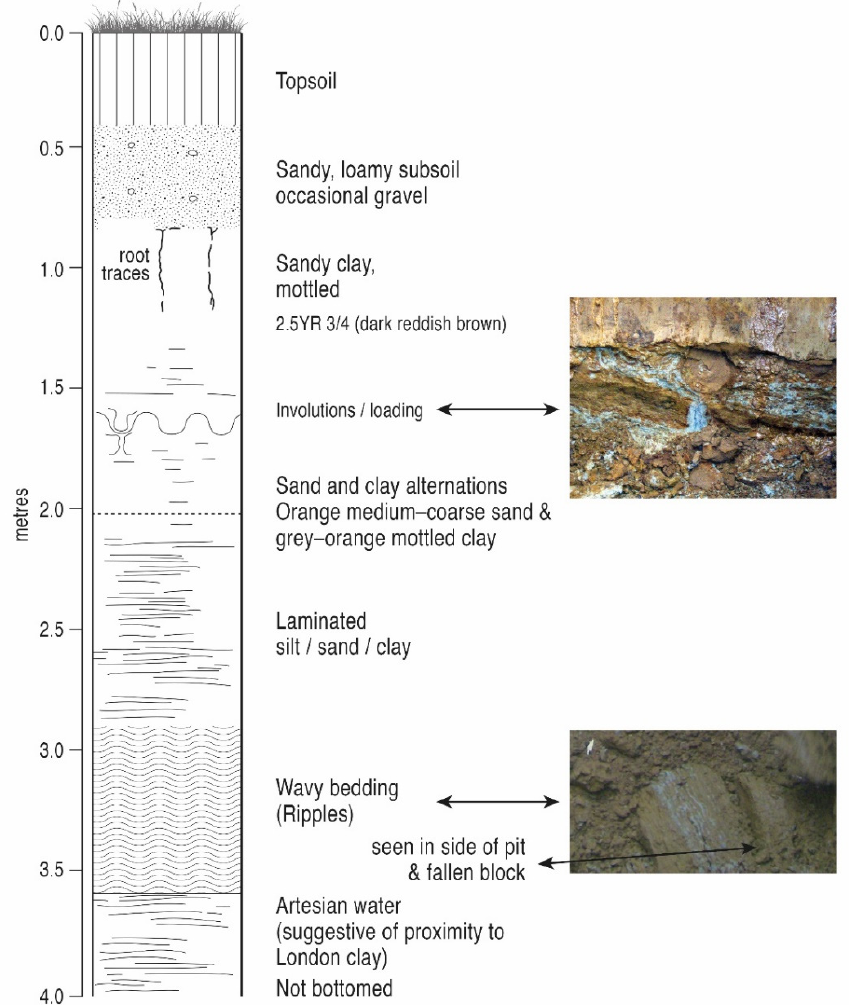
Figure 11. The Pound Farm 2014 archaeological assessment, test pit 6, the deepest excavated at the site. Photographs are inserted to illustrate cryoturbation and/or loading structures and ripple-lami- nated